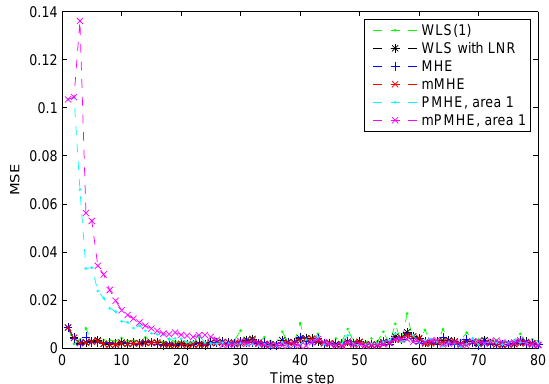
Figure 6. The Mean Square Error (MSE) of WLS(1) (the horizon length of measurements is 1), MHE, mMHE, PMHE and mPMHE with constraints, under the non-Gaussian noise assumption.